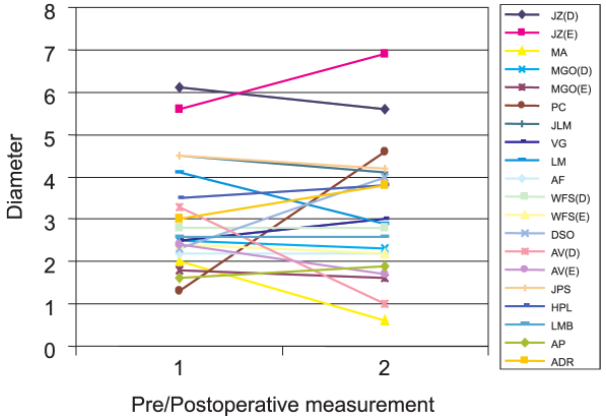
Figure 2 - Variation in aneurysmal sac diameter during postoperative follow-